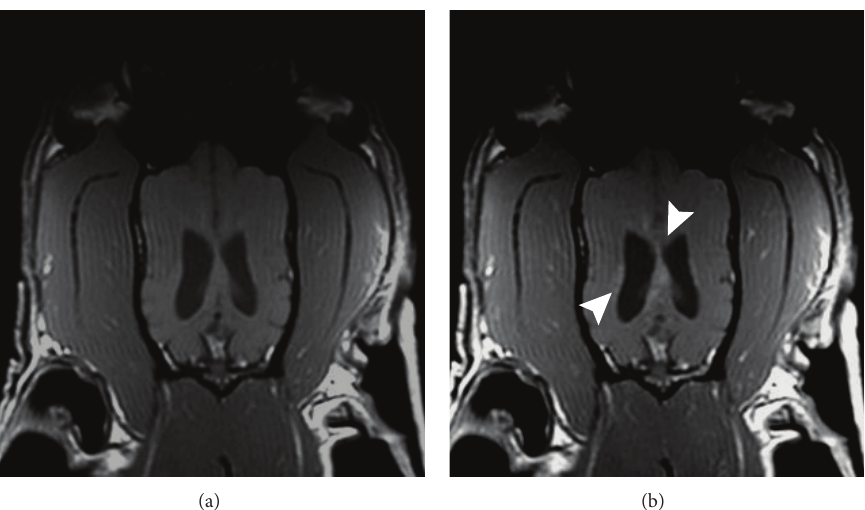
Figure 3: T1-weighted dorsal pulse sequences before (a) and after contrast (b), at the level of the lateral ventricles. (a) The T1-weighted precontrast images were unremarkable. (b) On the T1-weighted postcontrast sequence, multiple ill-defined mildly enhancing lesions were visible within the right frontal lobe, temporal lobe, and corpus callosum and surrounding the lateral ventricles (solid arrowheads).